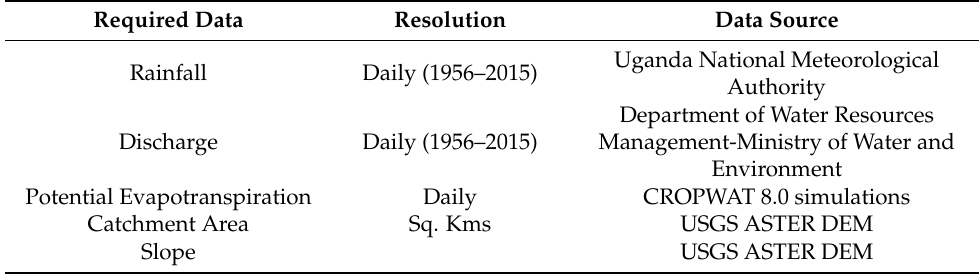
Table 1. NAM model input data.